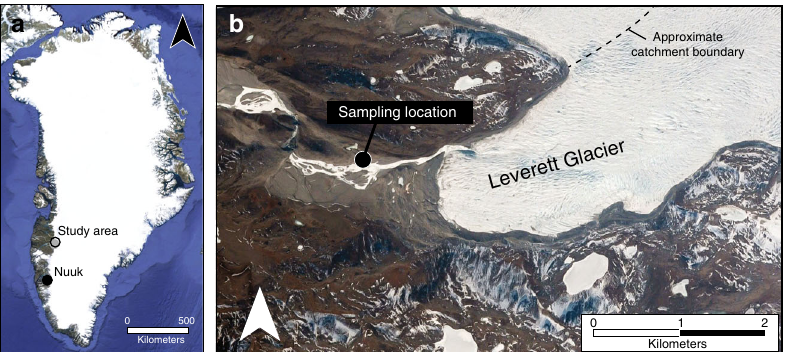
Fig. 1 Location of Leverett Glacier. a Indicates the location of the study area in southwest Greenland. Samples were collected from the proglacial river of Leverett Glacier ( b ) as per Hawkings et al. 22, 44, 64 and Lawson et al. 83 . Image ( a ) of Greenland is from Landsat (US Geological Survey, via Google), and image ( b ) of Leverett Glacier terminus is from DigitalGlobe (via Google)